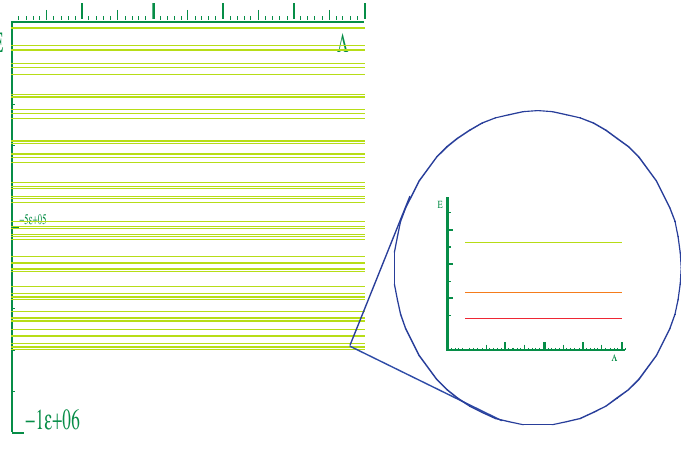
Figure 16. Energy spectrum, calculated for coupling value of 800,000.0 and (cid:1836) = 0 − 2 (cid:1853)(cid:1866)(cid:1856) ℓ = 0 − 40 . Zoom energy spectrum for the lowest energy band to far right.